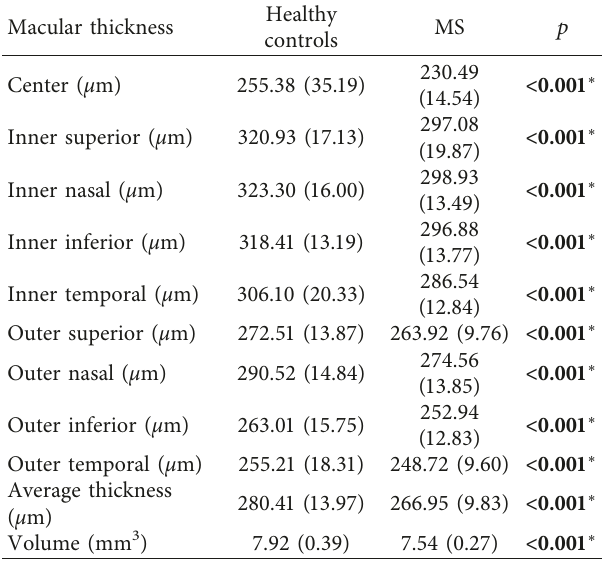
Numbers indicate mean values with standard deviation between brackets. Bold letters indicate statistical significance. ∗ Significant values after Bonferroni correction for multiple comparisons; MS, multiple